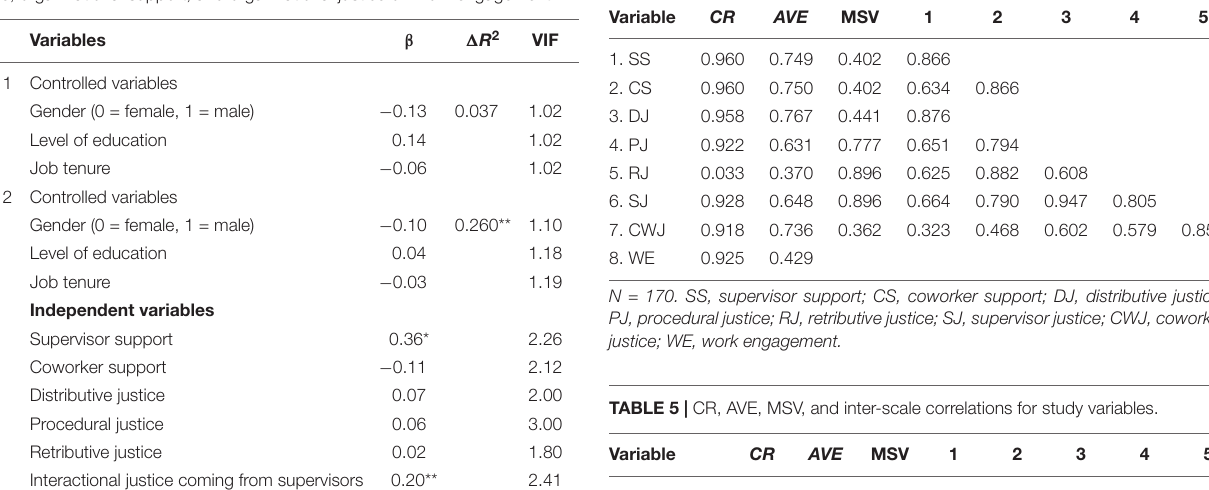
TABLE 4 | CR, AVE, MSV, and inter-scale correlations for study variables.